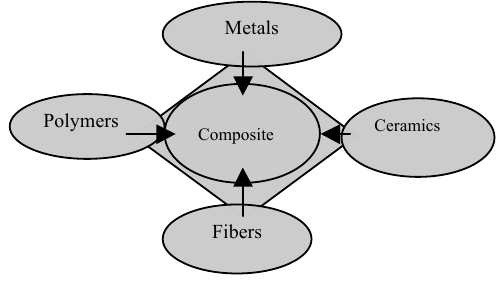
Composite Fig. 1: The material classes from which composite are made